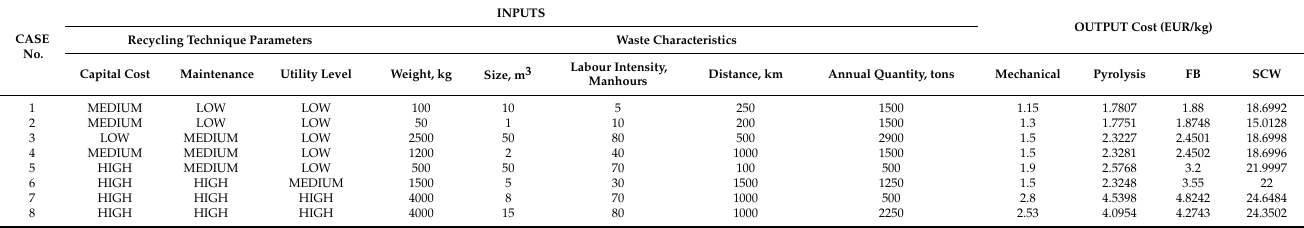
Table 7. Different case scenarios and predicted output cost for recycling